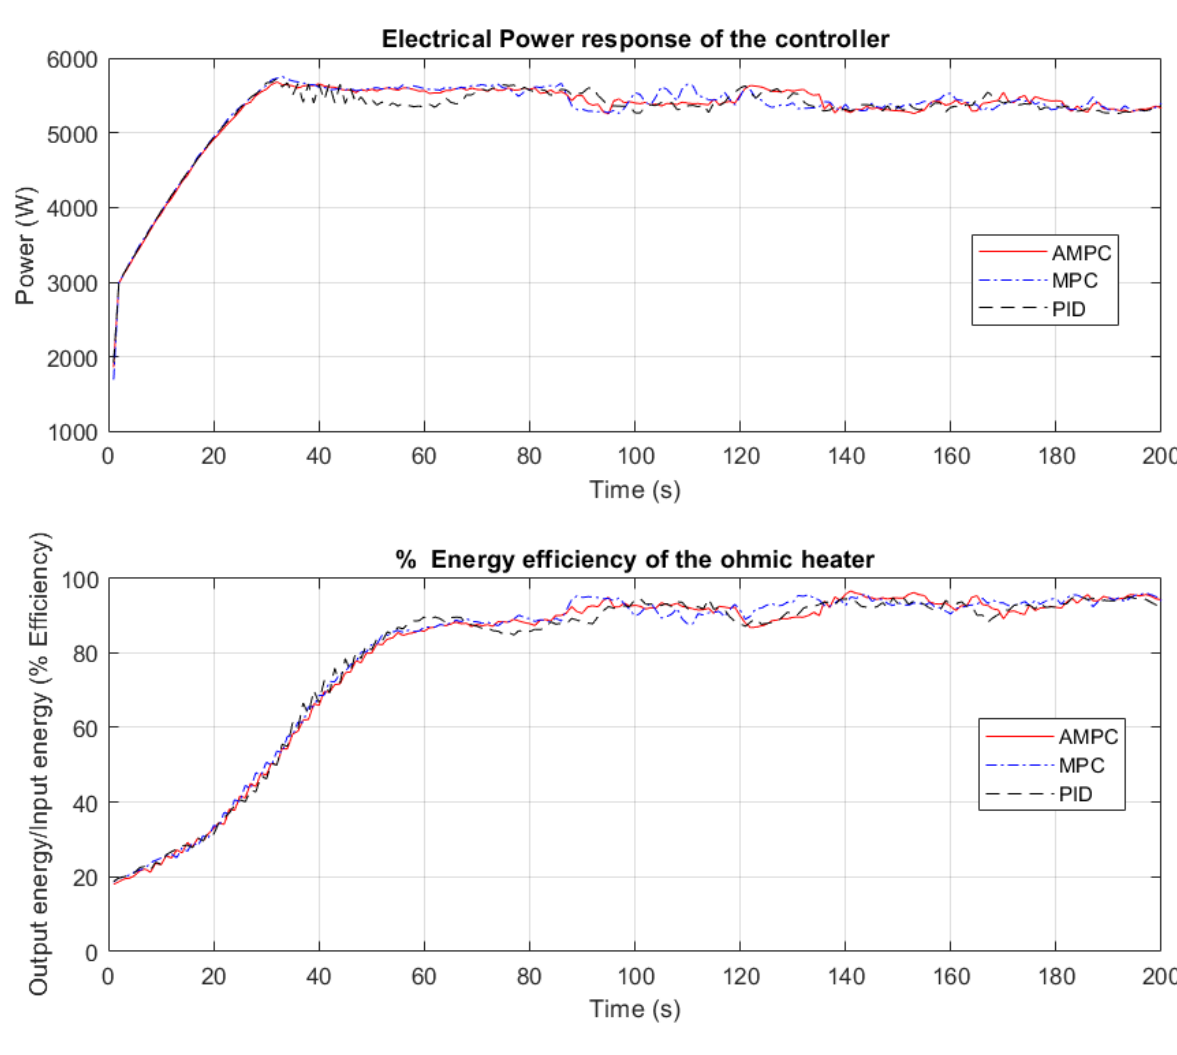
Figure 7. Electrical power and energy efficiency of the ohmic heater.